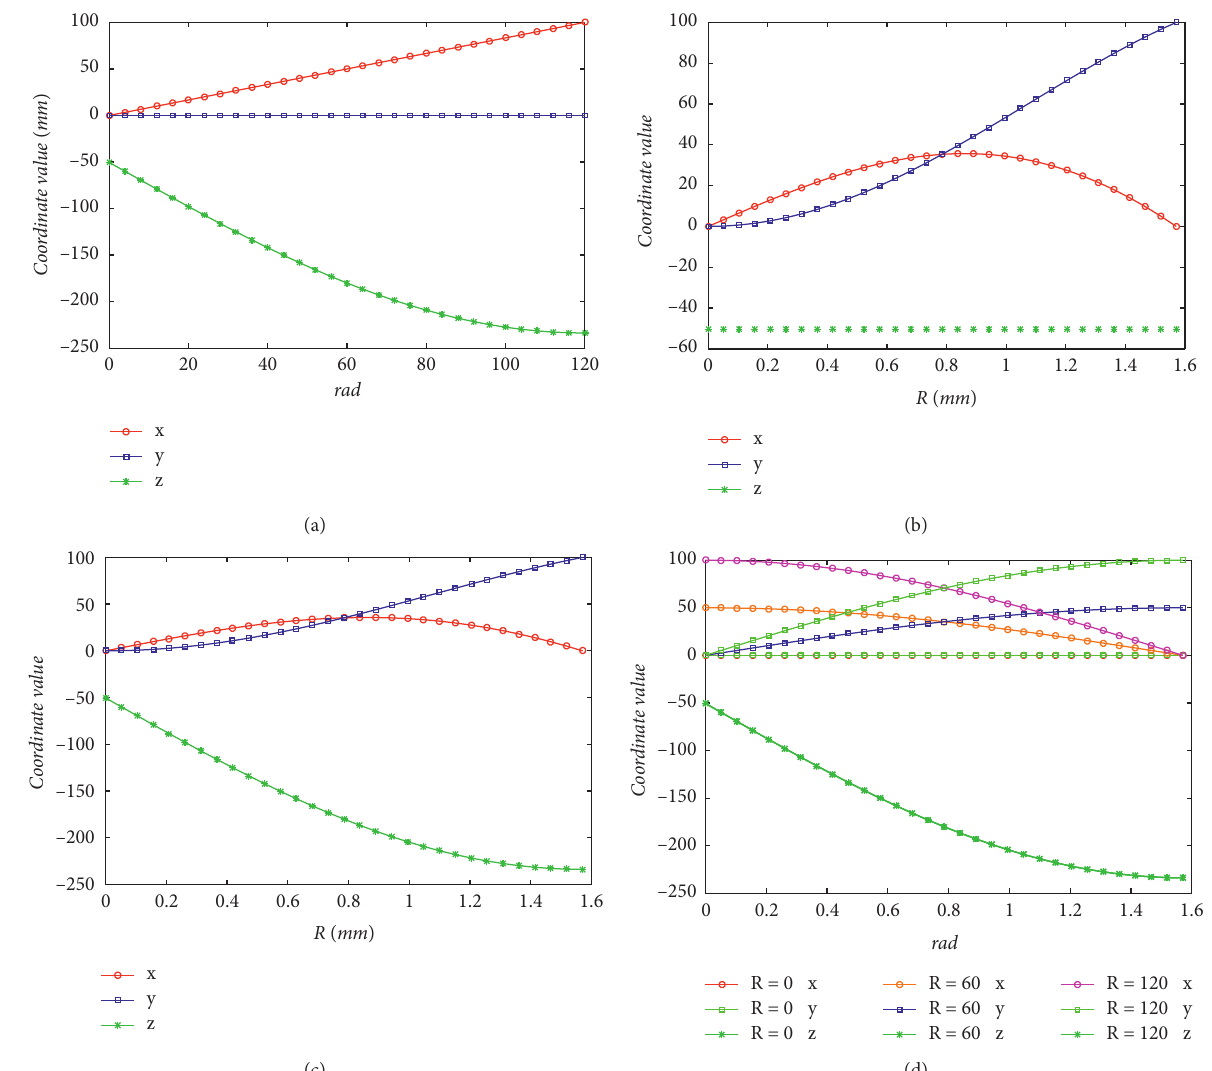
Figure 11: Barycenter varies with parameters. (a) R � 0–120, θ σ � 0–90 ° ; and (d) R � 0, 60, 120, θ a � 0–90 ° , σ � 0–90 ° .